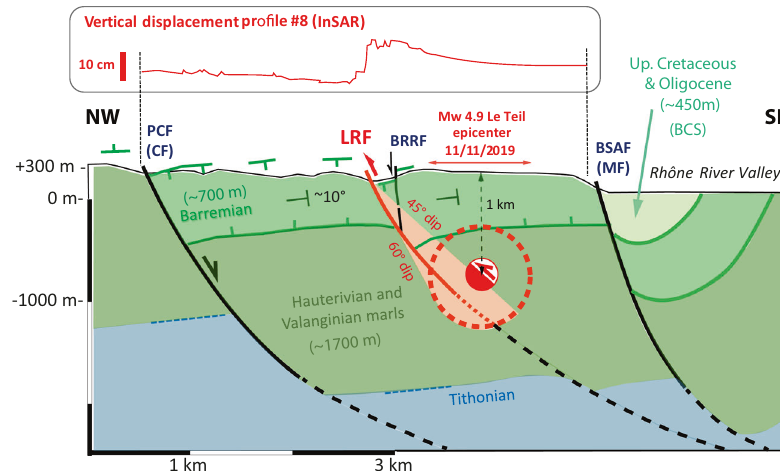
Fig. 9 Geological cross-section showing the possible relationship between the Oligocene inherited normal La Rouvière fault (LRF) and the reverse 11/11/2019 earthquake rupture (red). Thickness, dip, and location of geological formations are from the Aubenas geological map 4 . Elevation is from Google Earth extraction. PCF Pontet-de-Couloubre Fault, LRF La Rouvière Fault, BRRF Bayne-Roche-Renard Fault, BSAF Bayne-Saint-Alban Fault, BCS Bayne-Couijanet